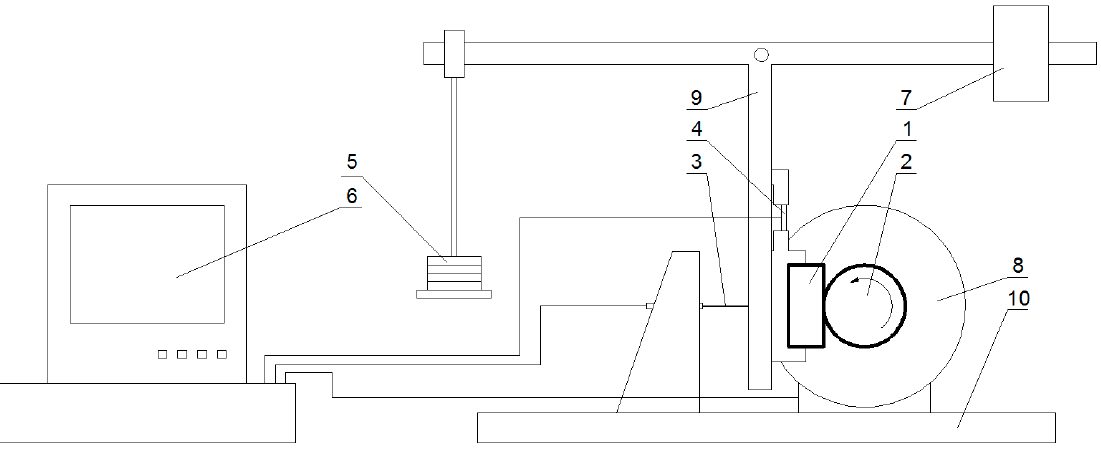
Figure 3. Diagram of the T-20 test stand: 1—sample, 2—counter-sample (sphere), 3—displacement sensor, 4—strain gauge for measuring friction force, 5—load, 6—computer, 7—counterweight, 8—electric motor, 9—swivel leaver, 10—deck.